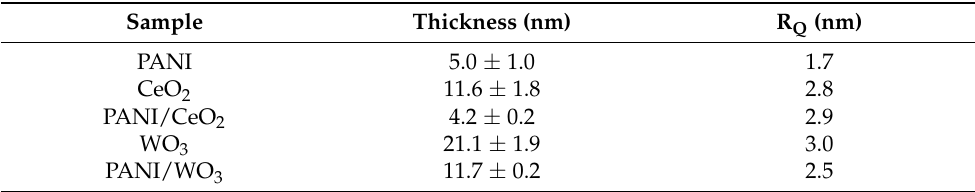
Table 1. The thickness and surface roughness, R Q (root mean square deviation), of the thin films from each group of